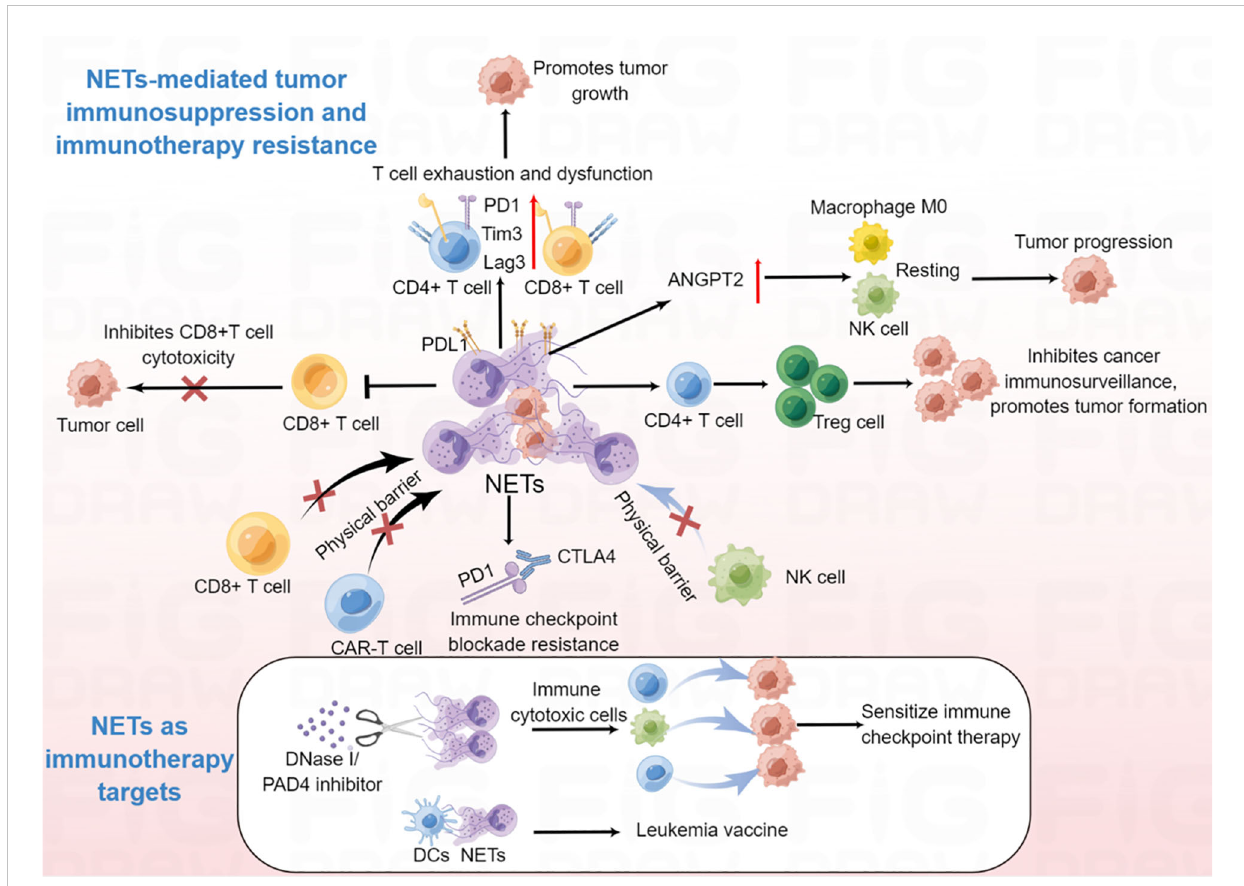
FIGURE 4 The emerging roles of NETs in the modulation of anti-tumor immunity and immunotherapy. NETs can promote CD4+ and CD8+ T cells exhaustion and dysfunction; NET-mediated physical barrier decreases the contact of immune cytotoxic cells (CD8+ T cell, NK cell and CAR-T cell) with tumor cells; NETs promote the differentiation of naïve CD4+ T cells into Tregs, which further contribute to tumor initiation and progression; NETs promote macrophage M0, NK cell resting. Degradation of NETs by DNase I can enhance the ef fi ciency of tumor immunotherapy; NET/DC vaccine may be used for leukemia